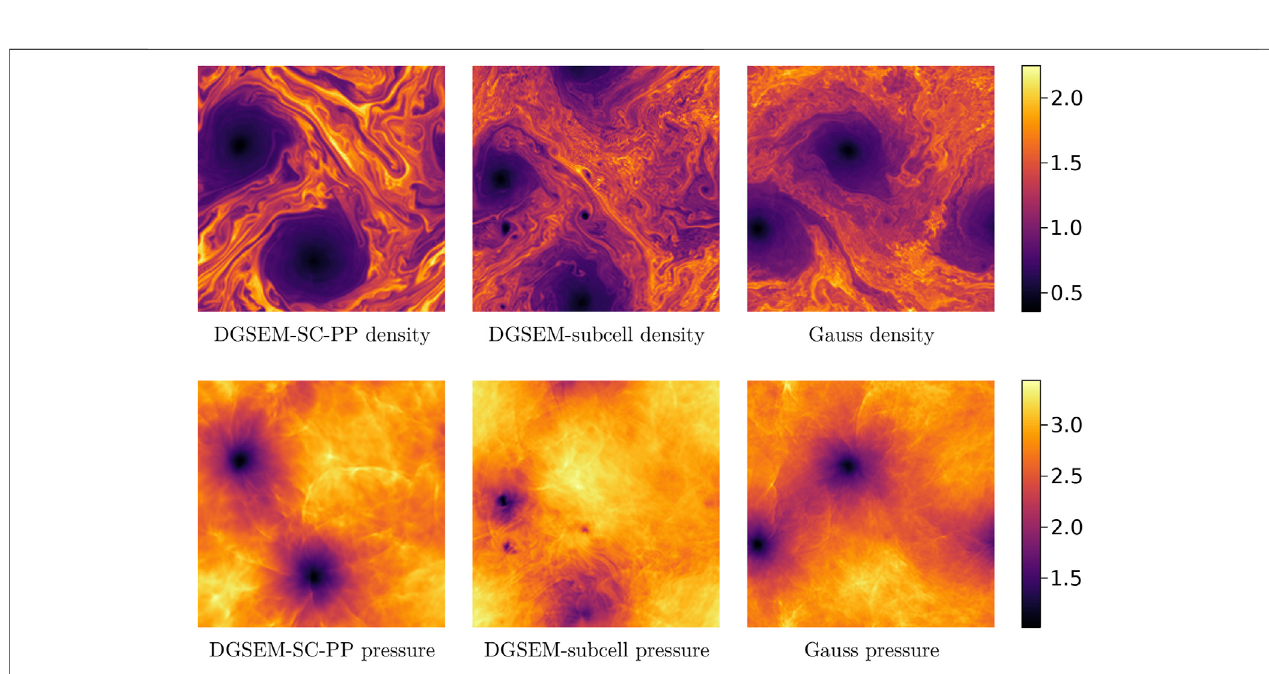
FIGURE 11 | Density and pressure for the Kelvin-Helmholtz instability at T fi nal = 25 on a N = 7 mesh of 32 2 elements.